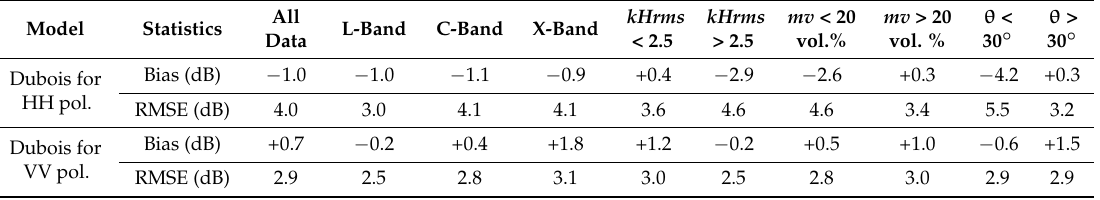
Table 2. Comparison between the Dubois model output and real data using the entire dataset, and by separating two intervals of kHrms , soil moisture ( mv ) and incidence angle ( θ ). Bias = real data −